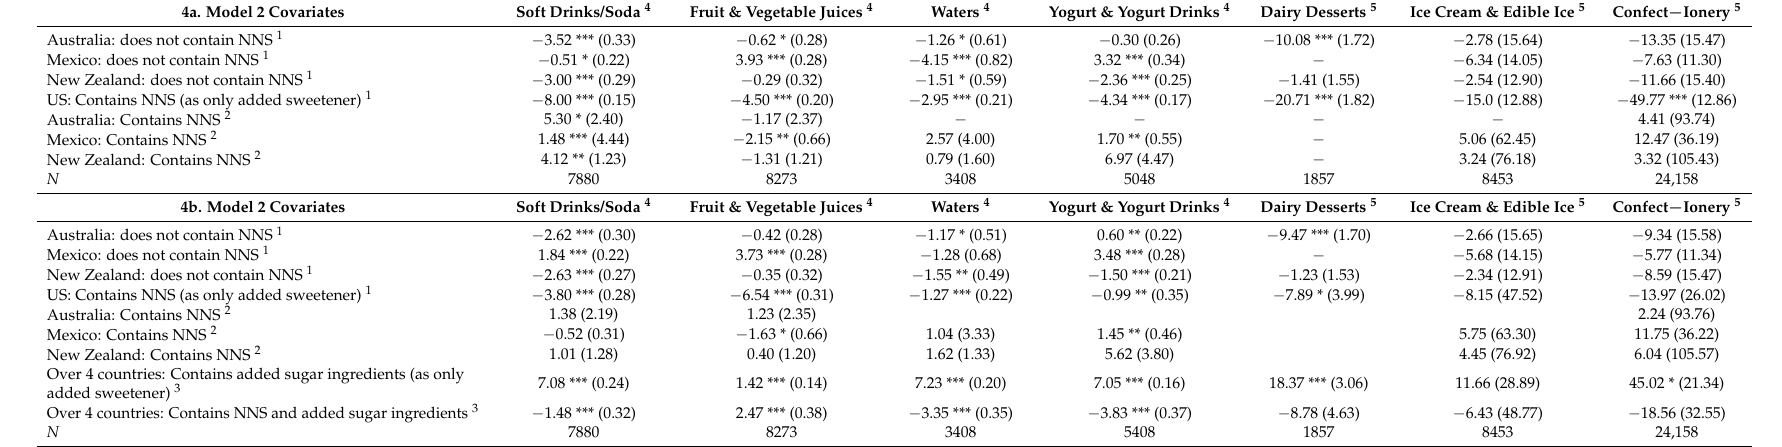
Table 4. Coefficient estimates (SE) of total sugar density for select food and beverage